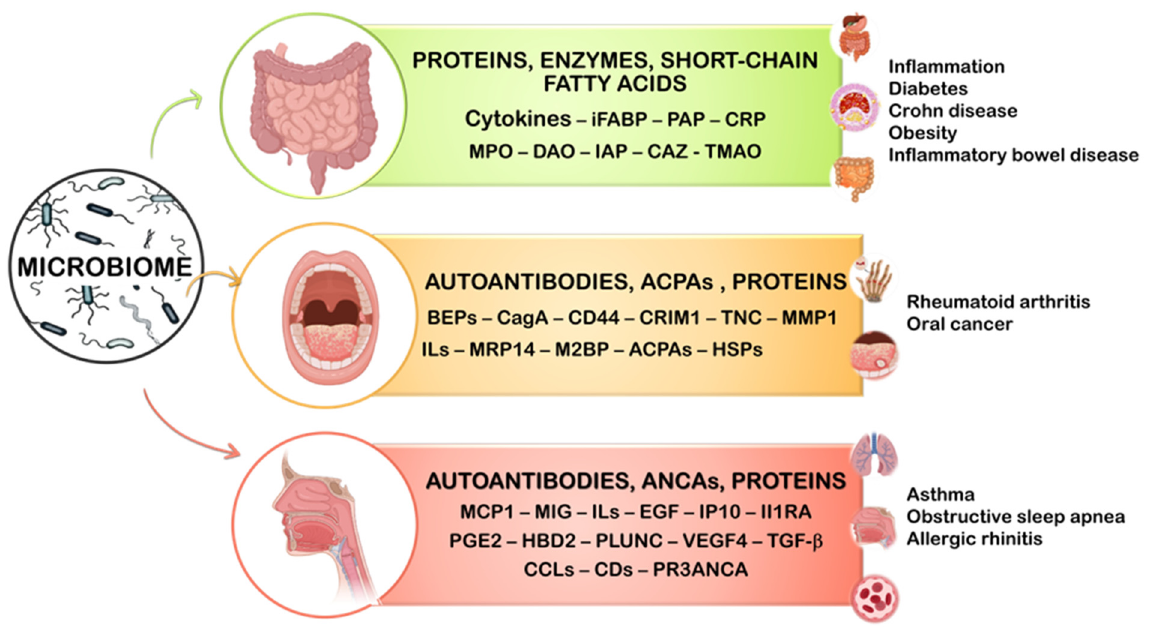
Figure 1. Selected gastrointestinal, oral, and nasal microbiome biomarkers and related diseases. Figure prepared by the authors.